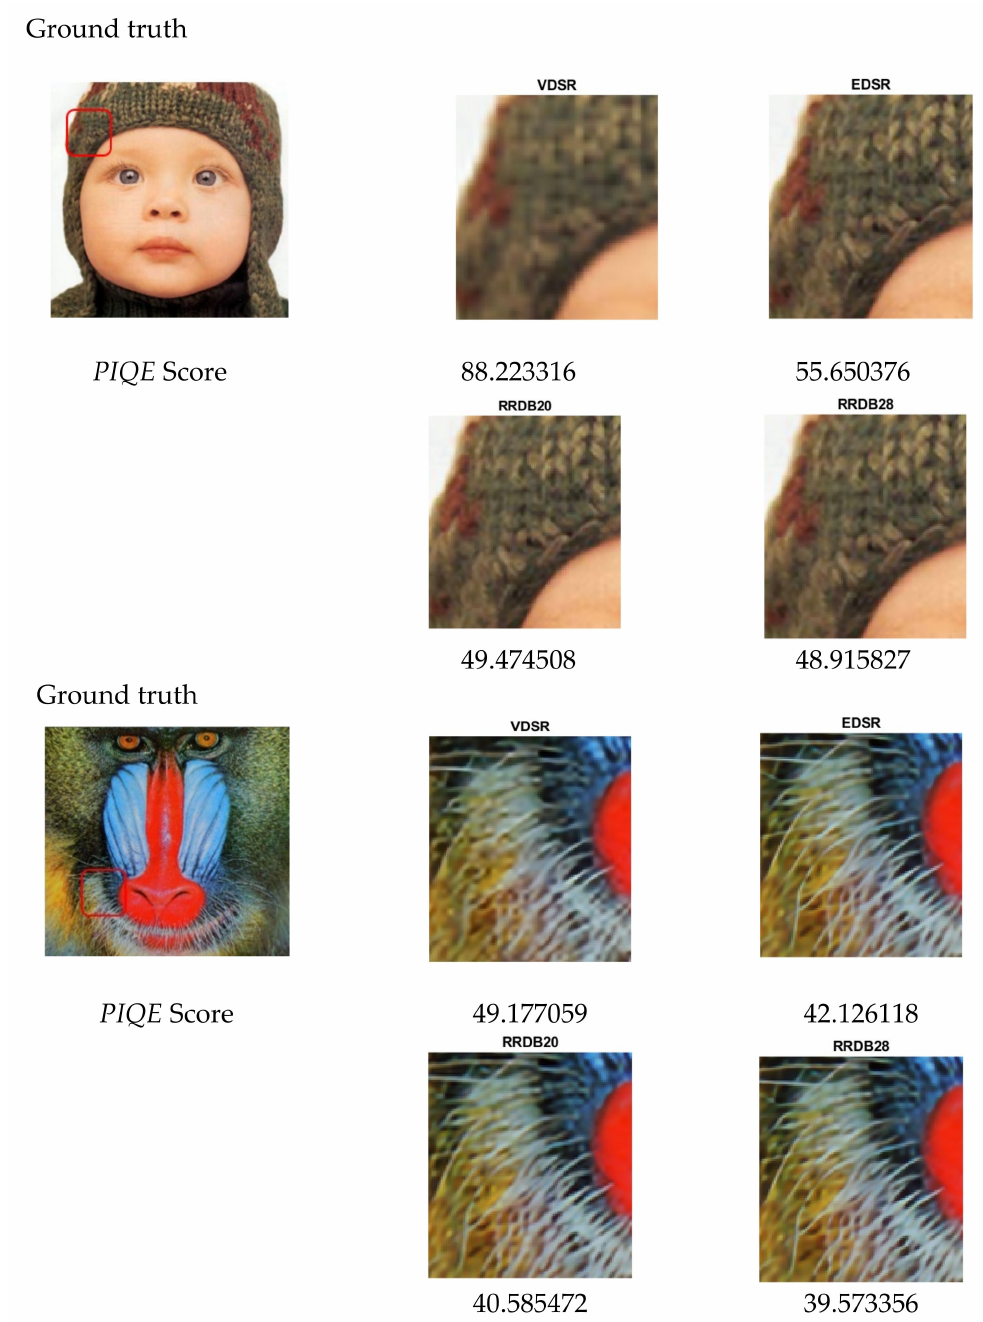
Figure 6. Perceptual evaluation of proposed models on set 5 ( × 2) and set 14 ( × 3)